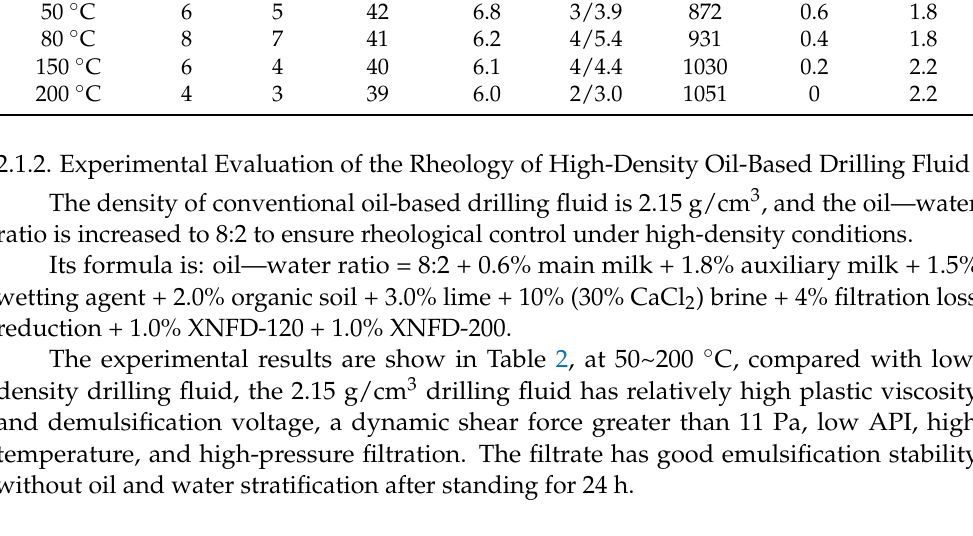
Table 2. Performance of oil-based drilling